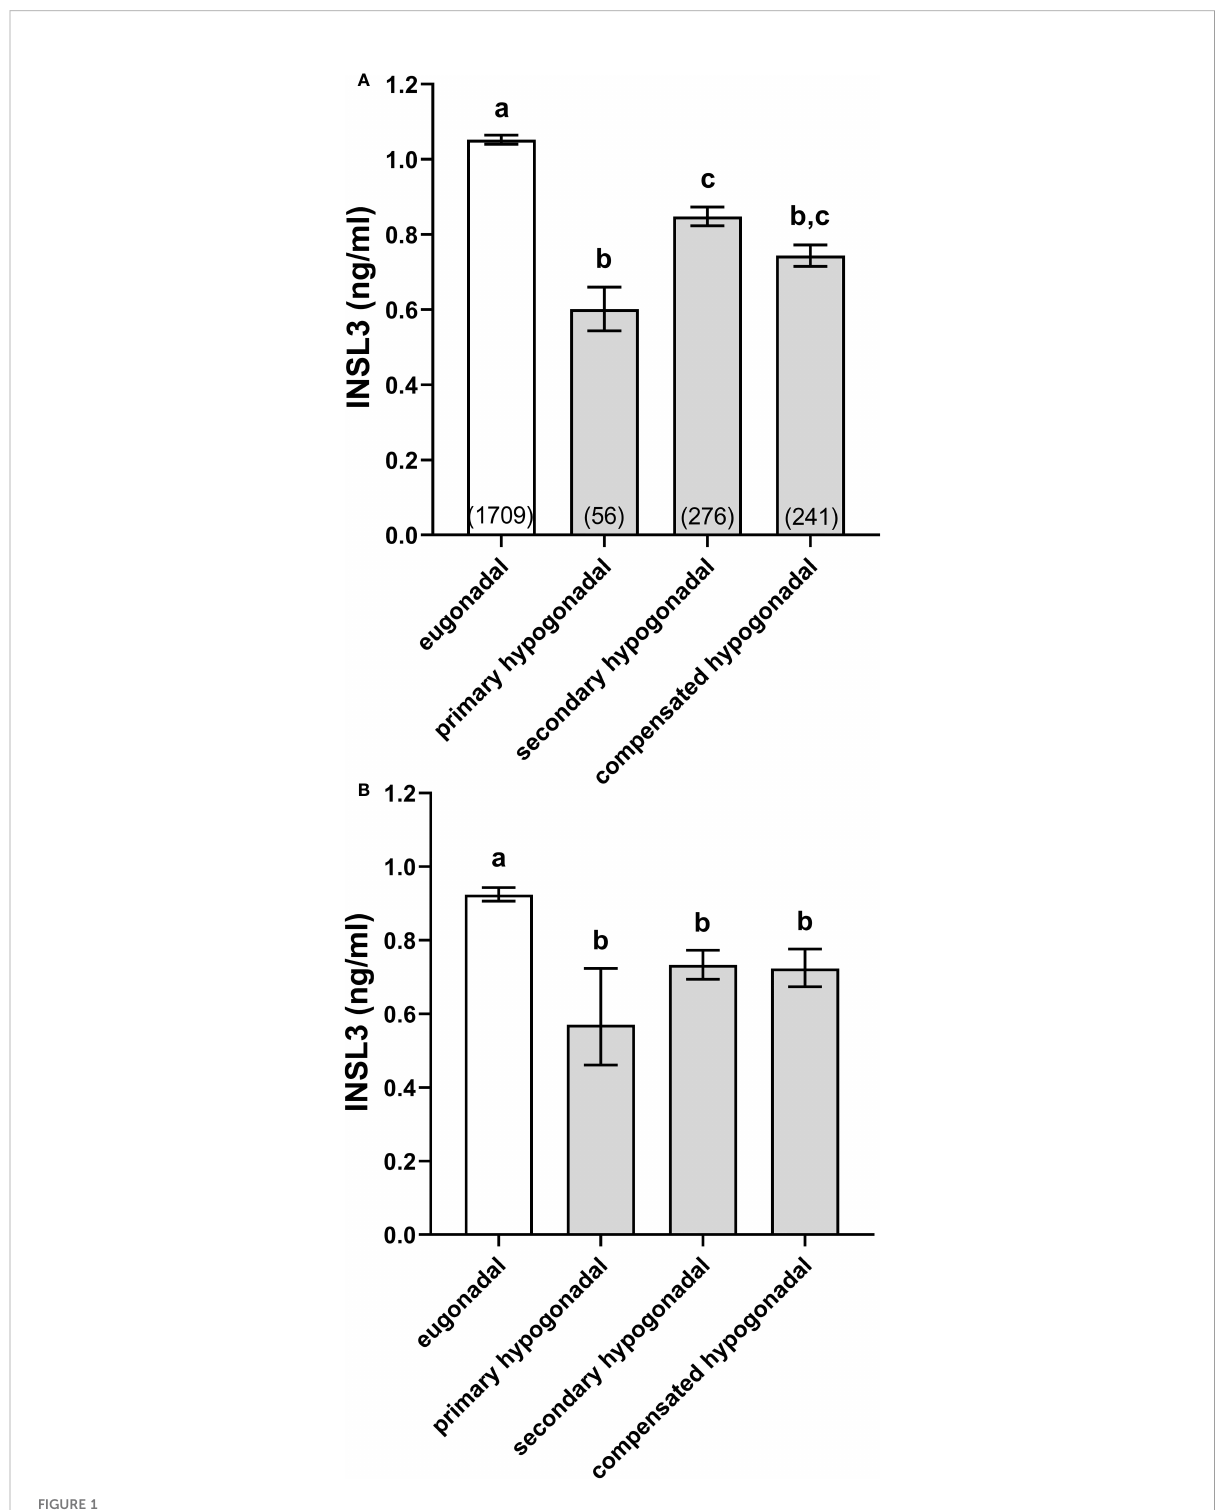
FIGURE 1 Simple means ± SEM for INSL3 (A) and age-adjusted INSL3 means and 95% con fi dence intervals (B) calculated by interpolation from individual INSL3 x age regressions for age 65 years, representing eugonadal (T>10.5 nmol/l; LH ≤ 9.4U/l), primary hypogonadal (T ≤ 10.5 nmol/l; LH>9.4 nmol/l), secondary hypogonadal (T ≤ 10.5 nmol/l; LH ≤ 9.4 nmol/l), and compensated hypogonadal (T>10.5 nmol/l; LH>9.4 nmol/l) subjects according to the criteria of Tajar et al. (17). The numbers of subjects in each category are indicated in parentheses. (a-c) different letters above the columns indicate signi fi cant differences between the columns, p<0.001; similar letters indicate no signi fi cant